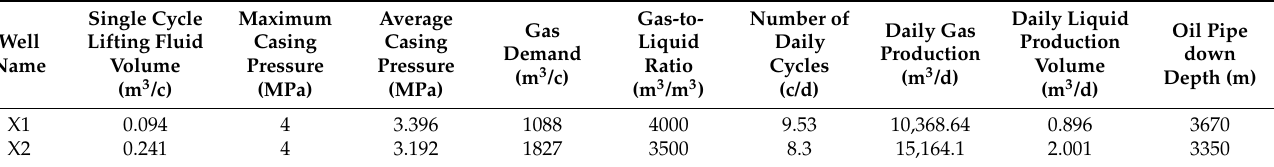
Table 3. Gas-well design